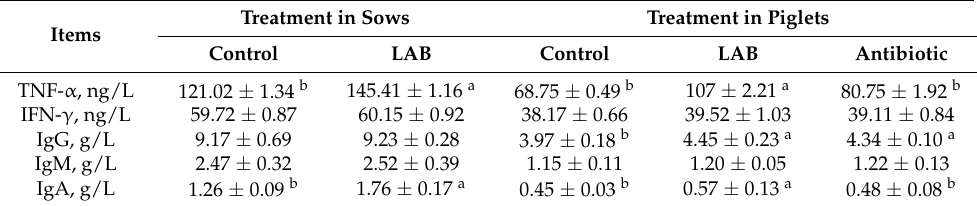
Figure 6. Effects of LAB on antioxidant capacity of serum in sows and weaned piglets. ( a , d ) T-SOD (U/mL), ( b , e ) T-AOC (U/mL), ( c , f ) MDA (nmol/mL), are antioxidant capacity of serum in sows and weaned piglets, respectively. For sows, control, basal diet ( N = 18); LAB, basal diet + 6% mixed selected LAB strains ( N = 18). For piglets, control, basal diet ( N = 30); LAB, basal diet + 6% mixed selected LAB strains ( N = 30); antibiotic, basal diet + 150 mg/kg of aureomycin ( N = 30). T-SOD, total superoxide dismutase; T-AOC, total antioxidant capacity; MDA, malondialdehyde. Asterisks denotes significant differences compared with the control group (* p < 0.05). Table 7. Effects of LAB on immune indexes of serum in sows and weaned